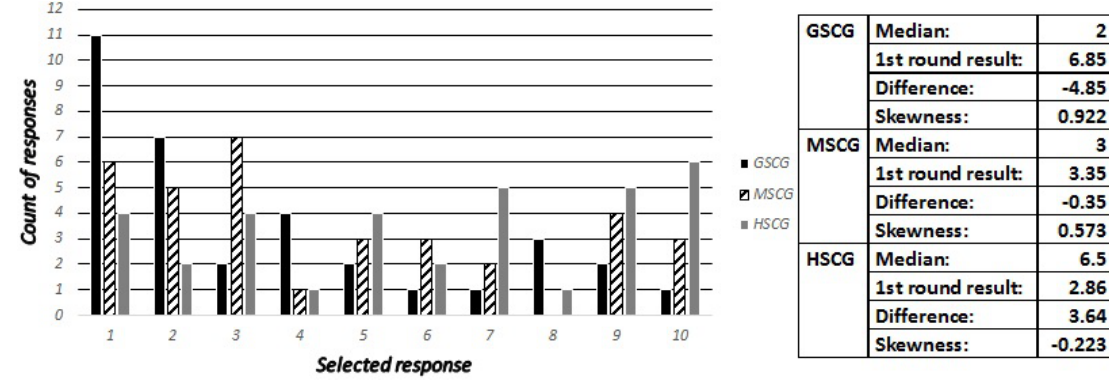
Figure 7. Expert predictions for question 5.